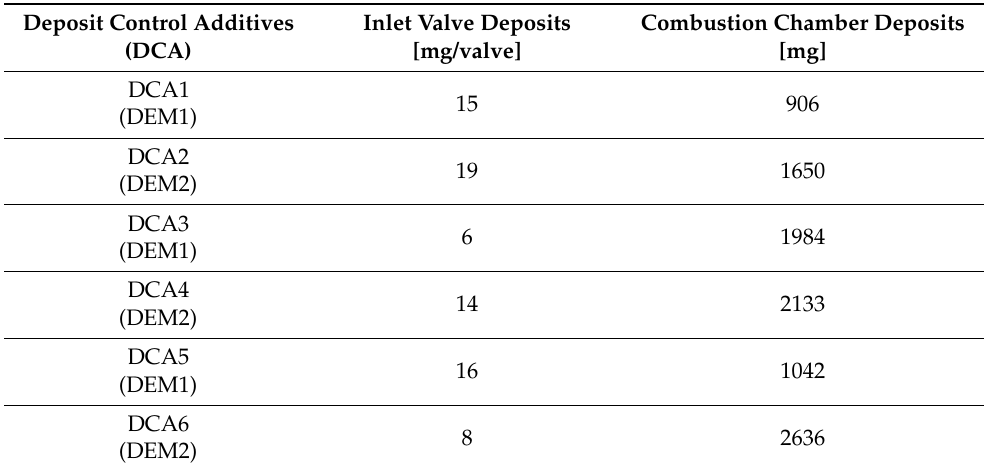
Table 5. Deposits on inlet valves, in combustion chambers, and in fuel injectors with different amounts of detergent-emulsifying additive and carrier